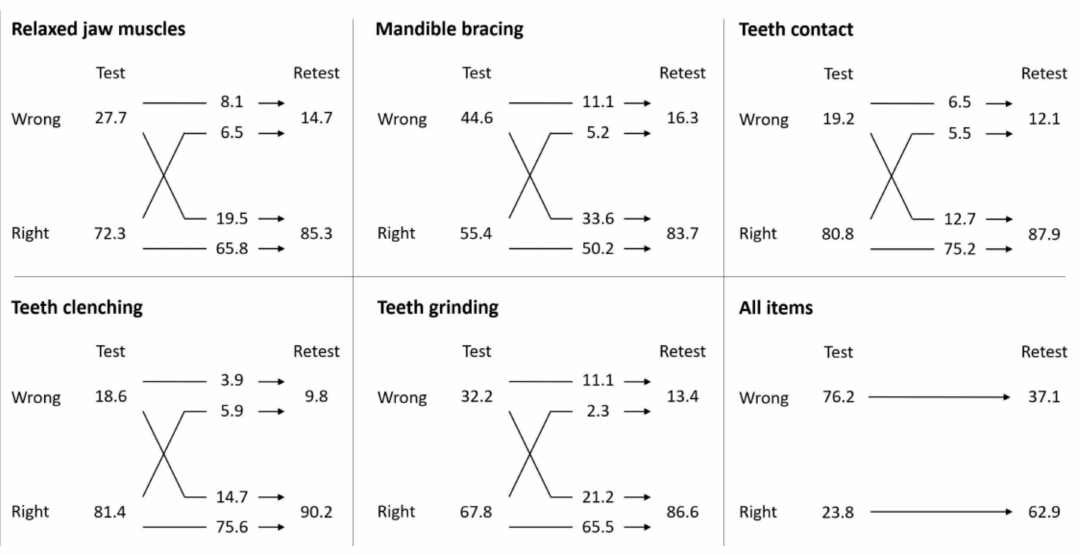
Figure 1. Summarized answers to the questions per item and to all items